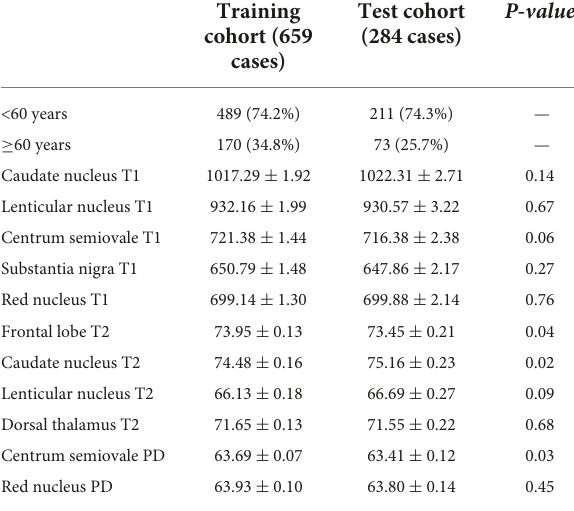
TABLE 1 Demographic characteristic of subjects in training and test